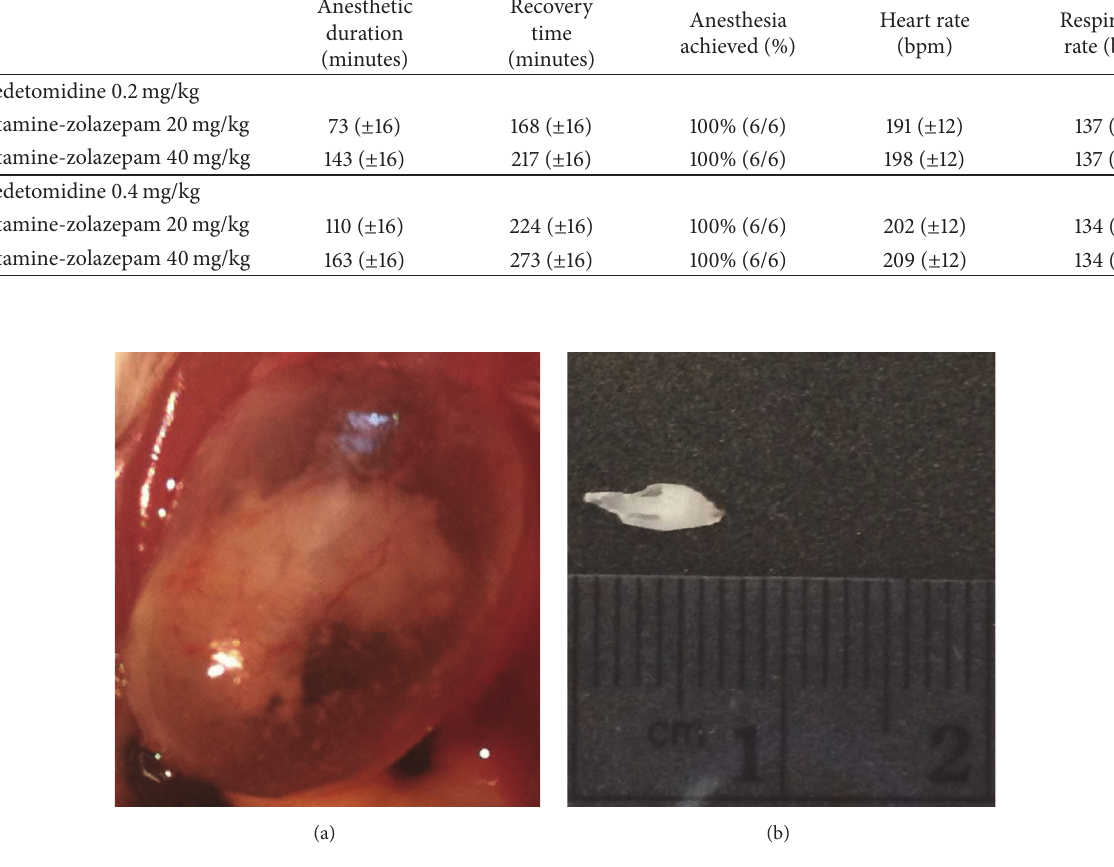
Figure 2: Urinary bladder with homogenous proteinaceous material within it (a) and seminal coagulum plug pulled from the urethra in a male mouse